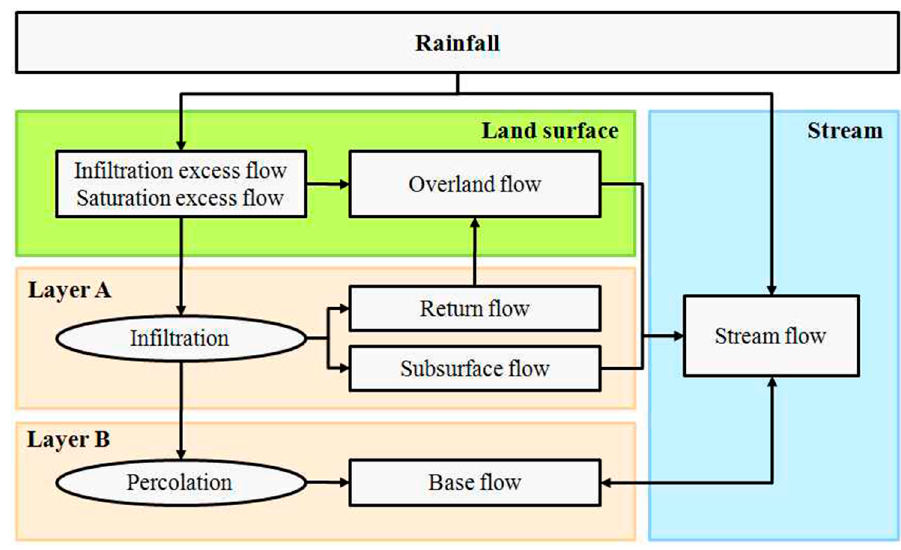
Figure 2. Schematic diagram of the grid-based rainfall–runoff model (GRM) (taken from [38]).